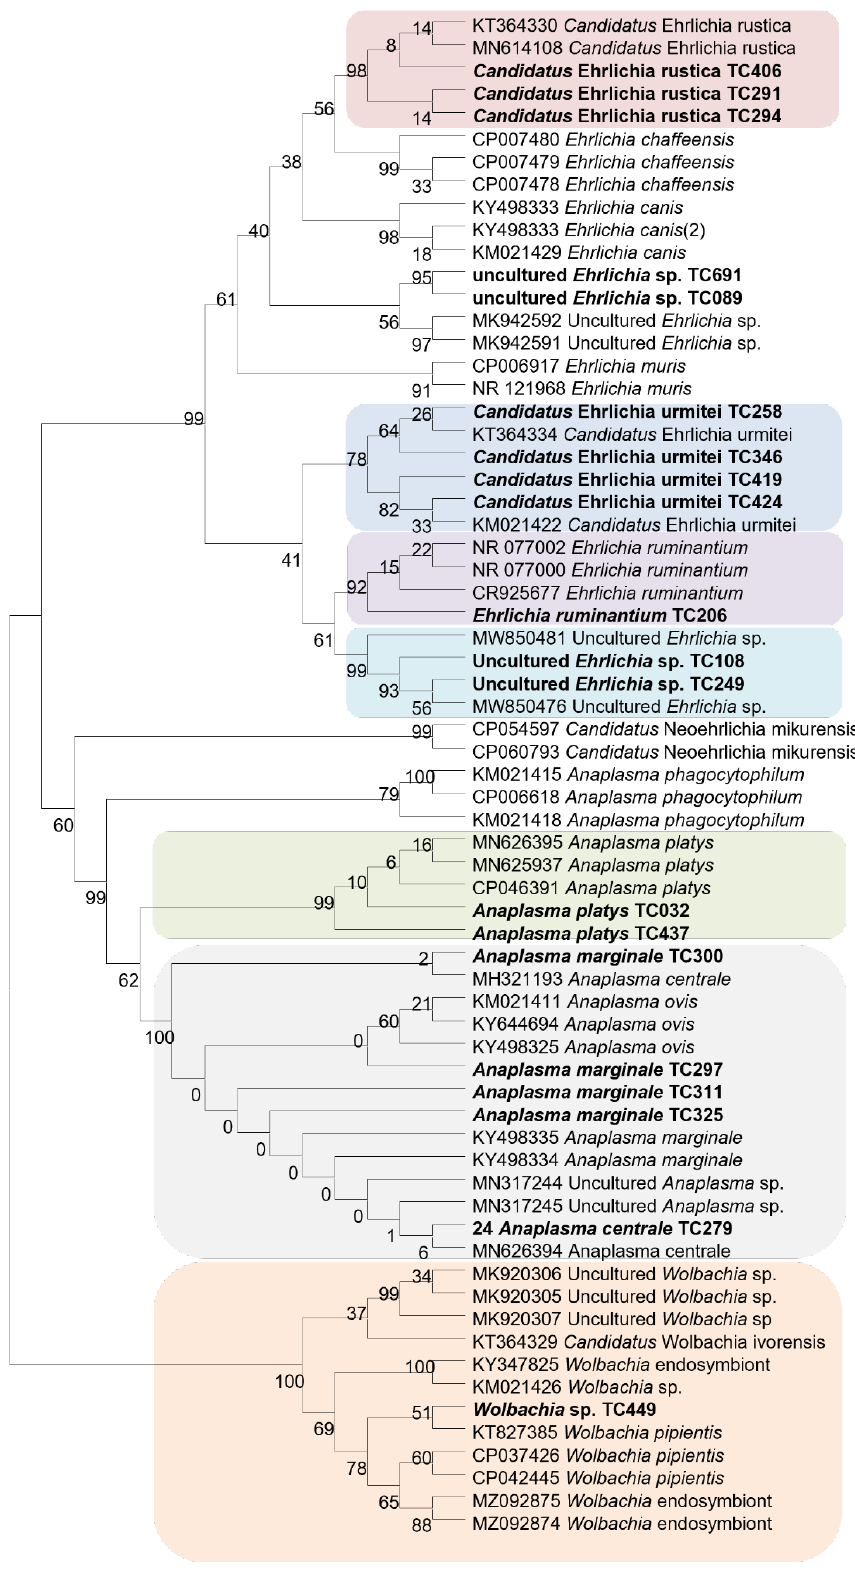
Figure 3. Phylogenetic tree of Anaplasmataceae detected in ticks from the Western Highlands of Cameroon Maximum likelihood method. The partial sequence of 23S rRNA gene from ticks collected in 2018 were aligned. Microorganisms sequenced in the current study are in bold.